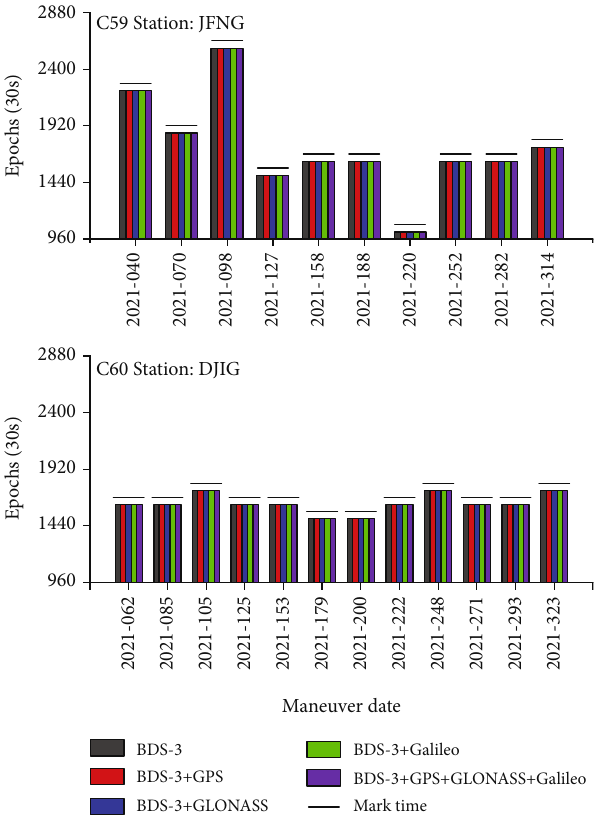
Figure 11: Comparison of detection results of C59 and C60 orbit maneuvering end time by di ff erent system